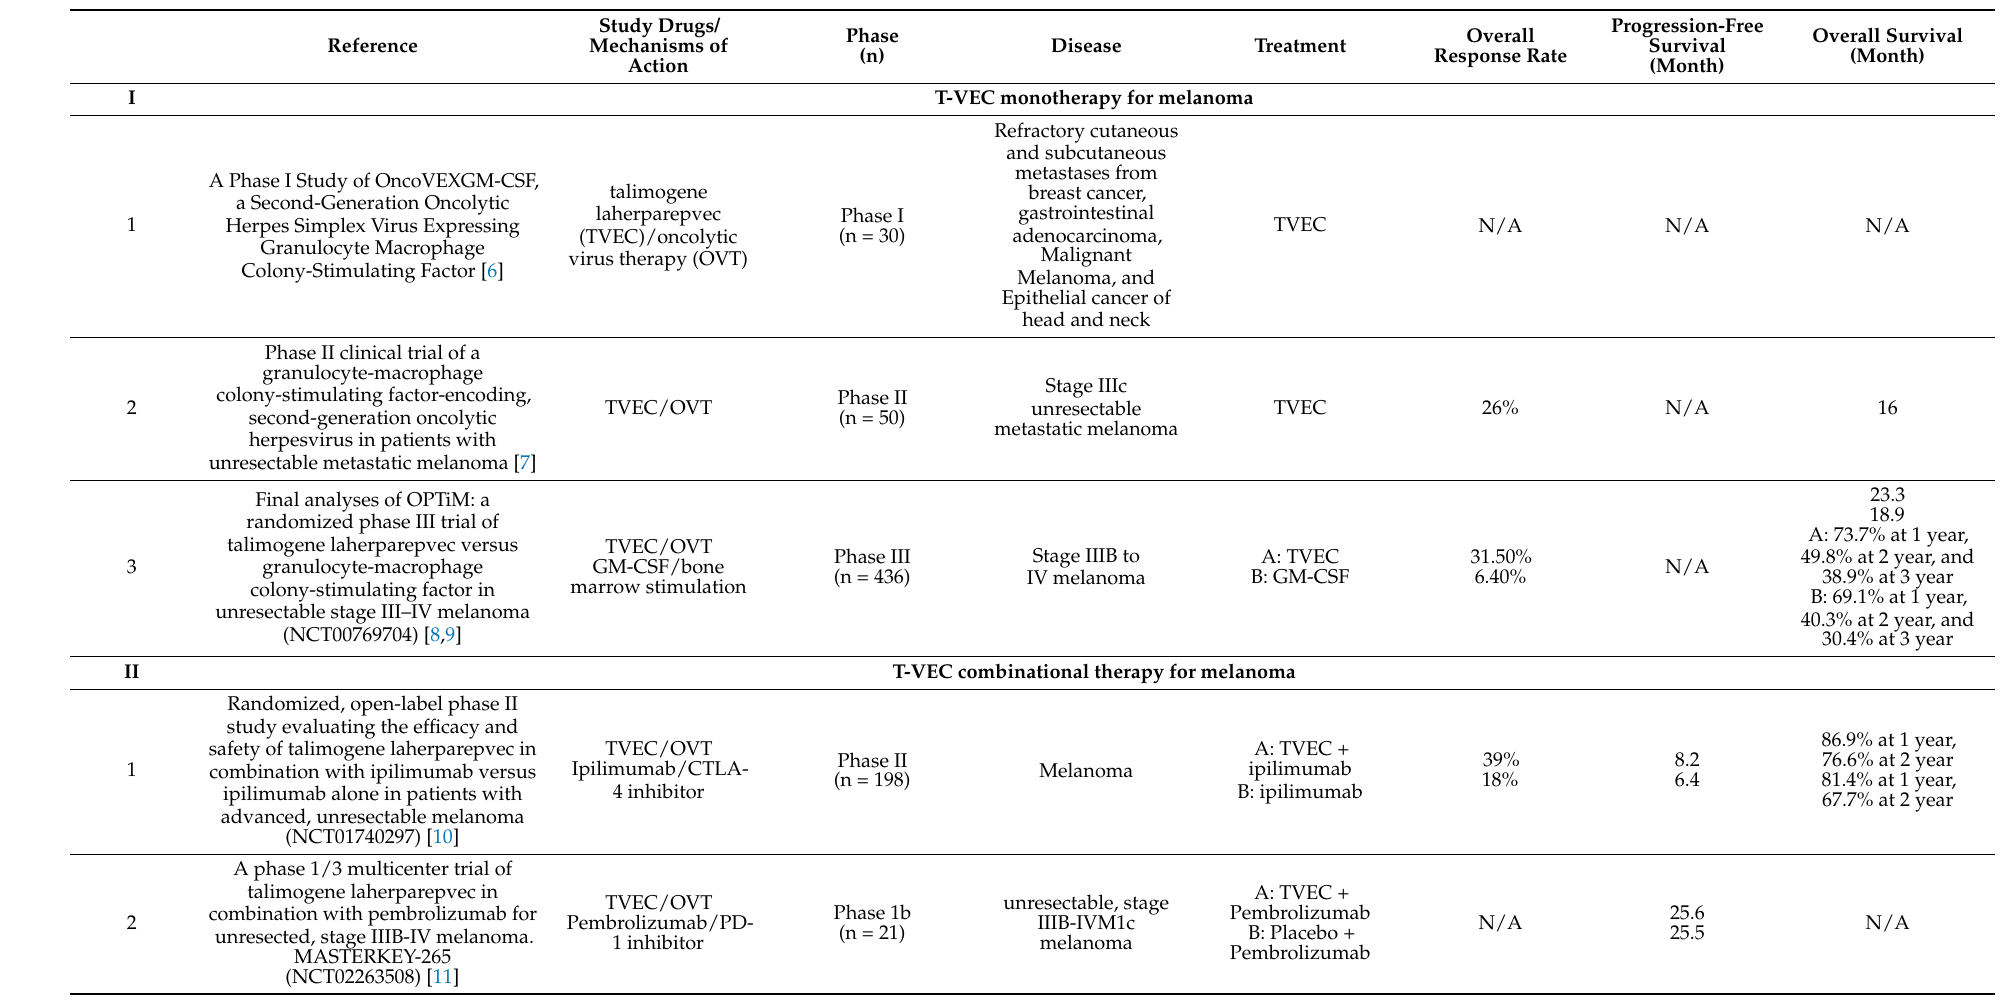
Table 1. Efficacy and safety of T-VEC monotherapies and combination therapies in the treatment of skin